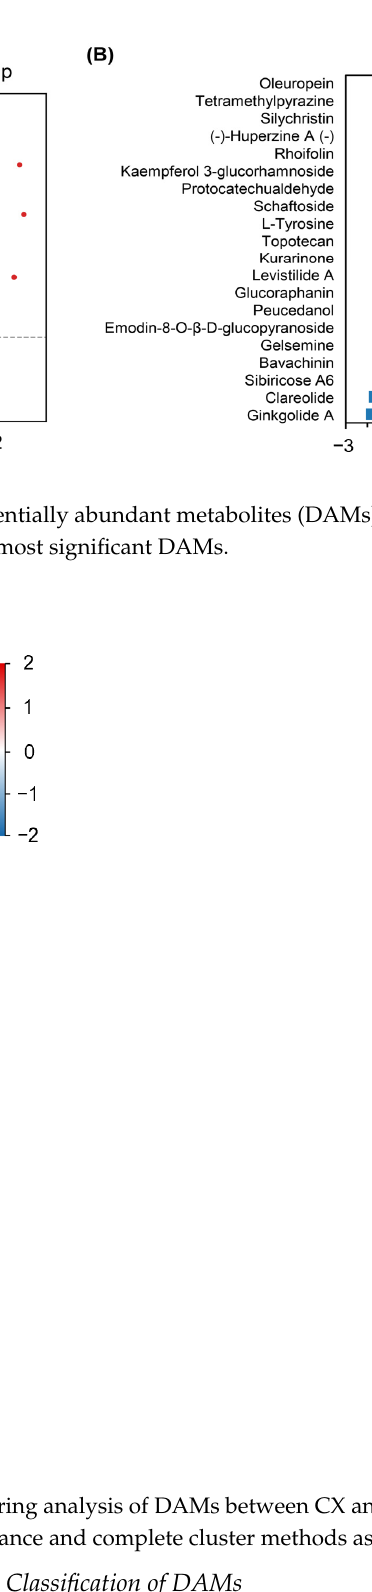
Figure 5. The hierarchical clustering analysis of DAMs between CX and LX. The heatmap of DAMs was displayed by Euclidean distance and complete cluster methods as a measurement of similarity.